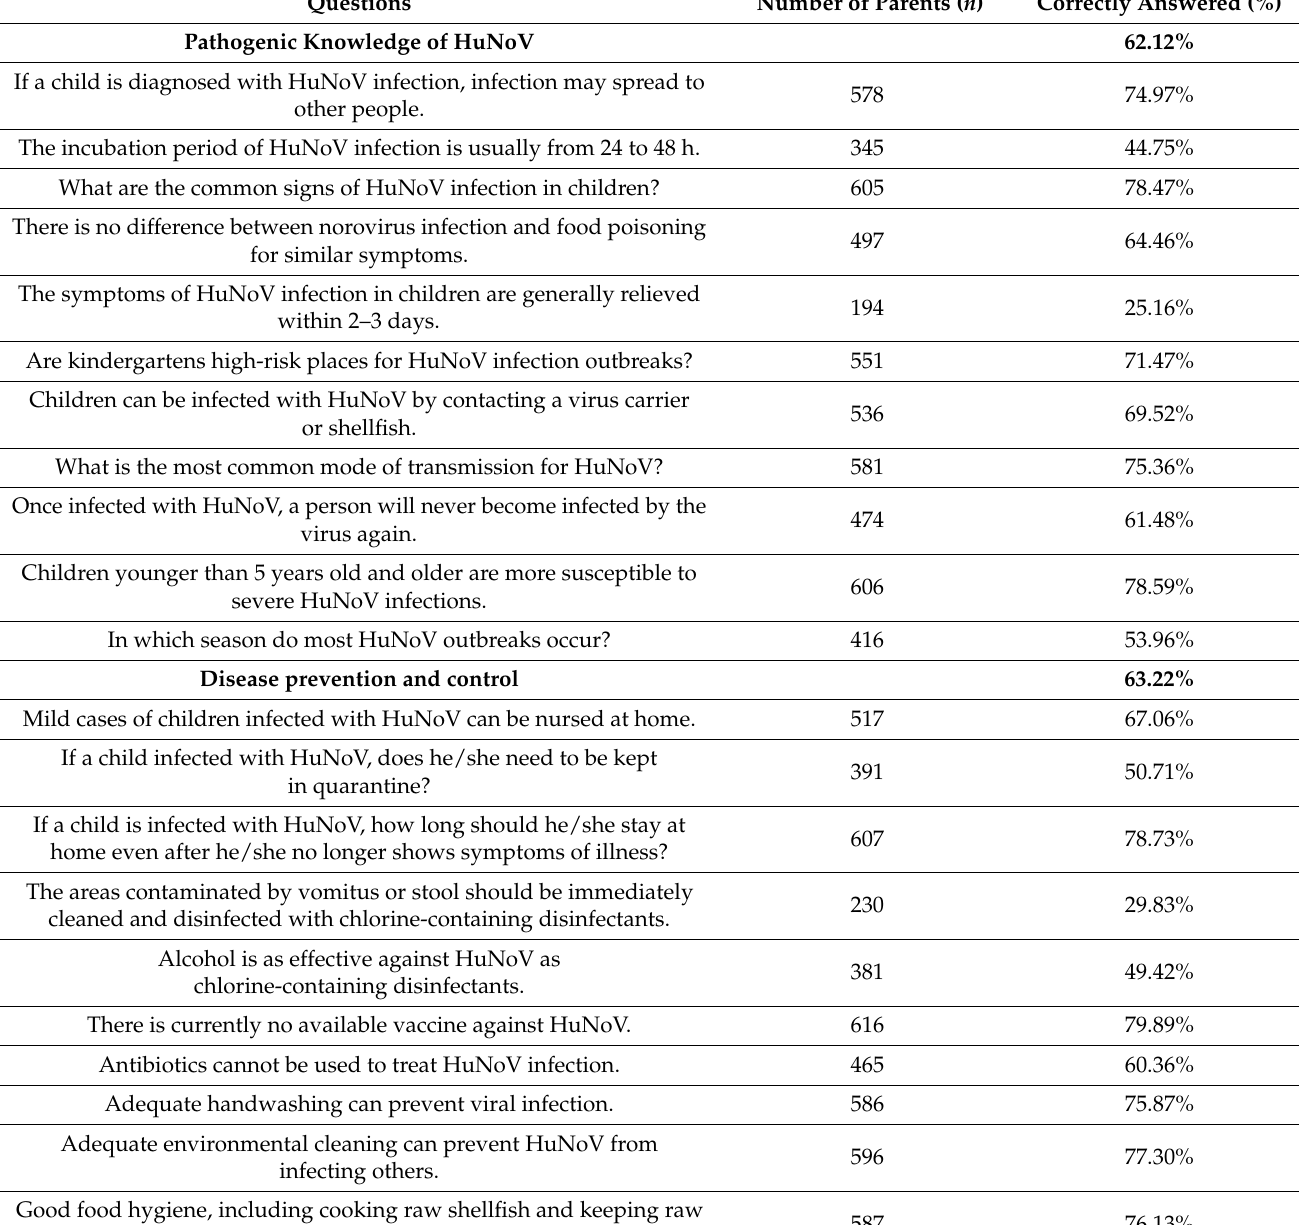
Table 2. Parents’ awareness about pathogenic knowledge of HuNoV, disease prevention, and